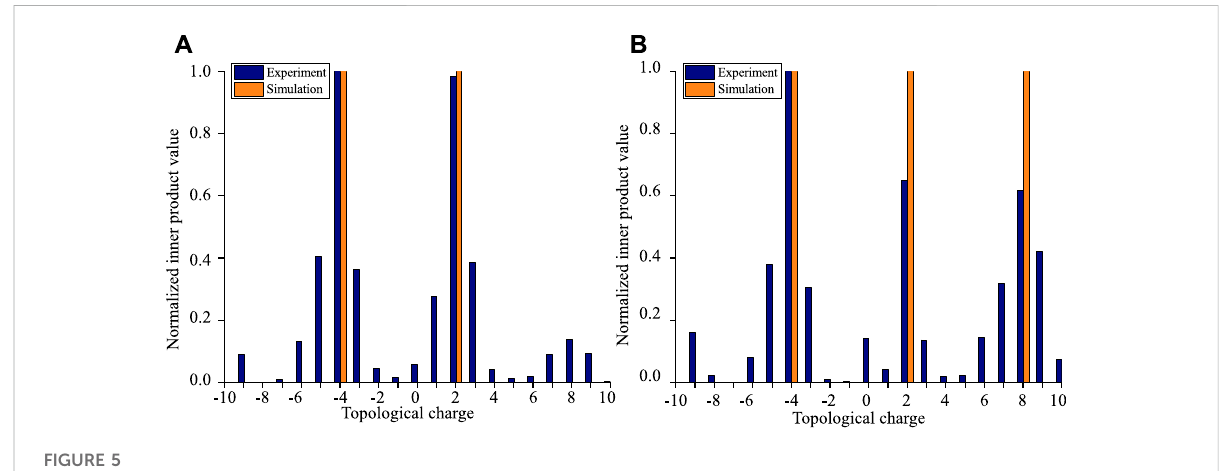
FIGURE 5 Inner product results of OAM superposition beams with (A) ℓ = 2, − 4 and (B) ℓ = 2, − 4,